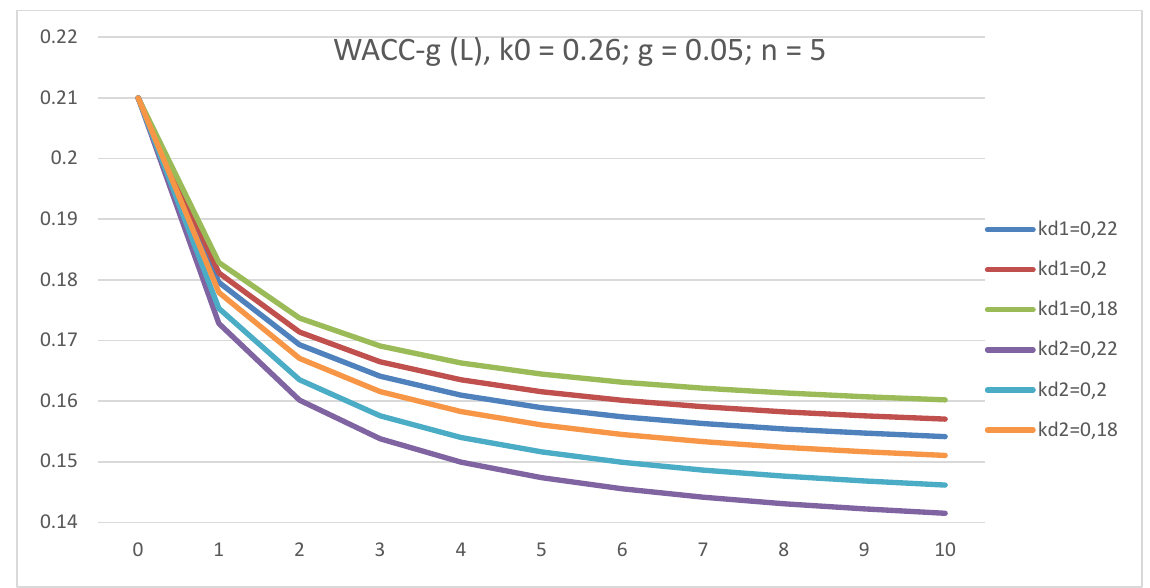
Figure 6. The dependence of discount rate, WACC–g, on leverage level, L, in GBFO theory with payments of tax on profit at the end of periods (1) and advance payments (2) at k 0 = 0.26; k d = 0.22; 0.2; 0.18; t = 0.2; g = 0.05, for a five-year company.